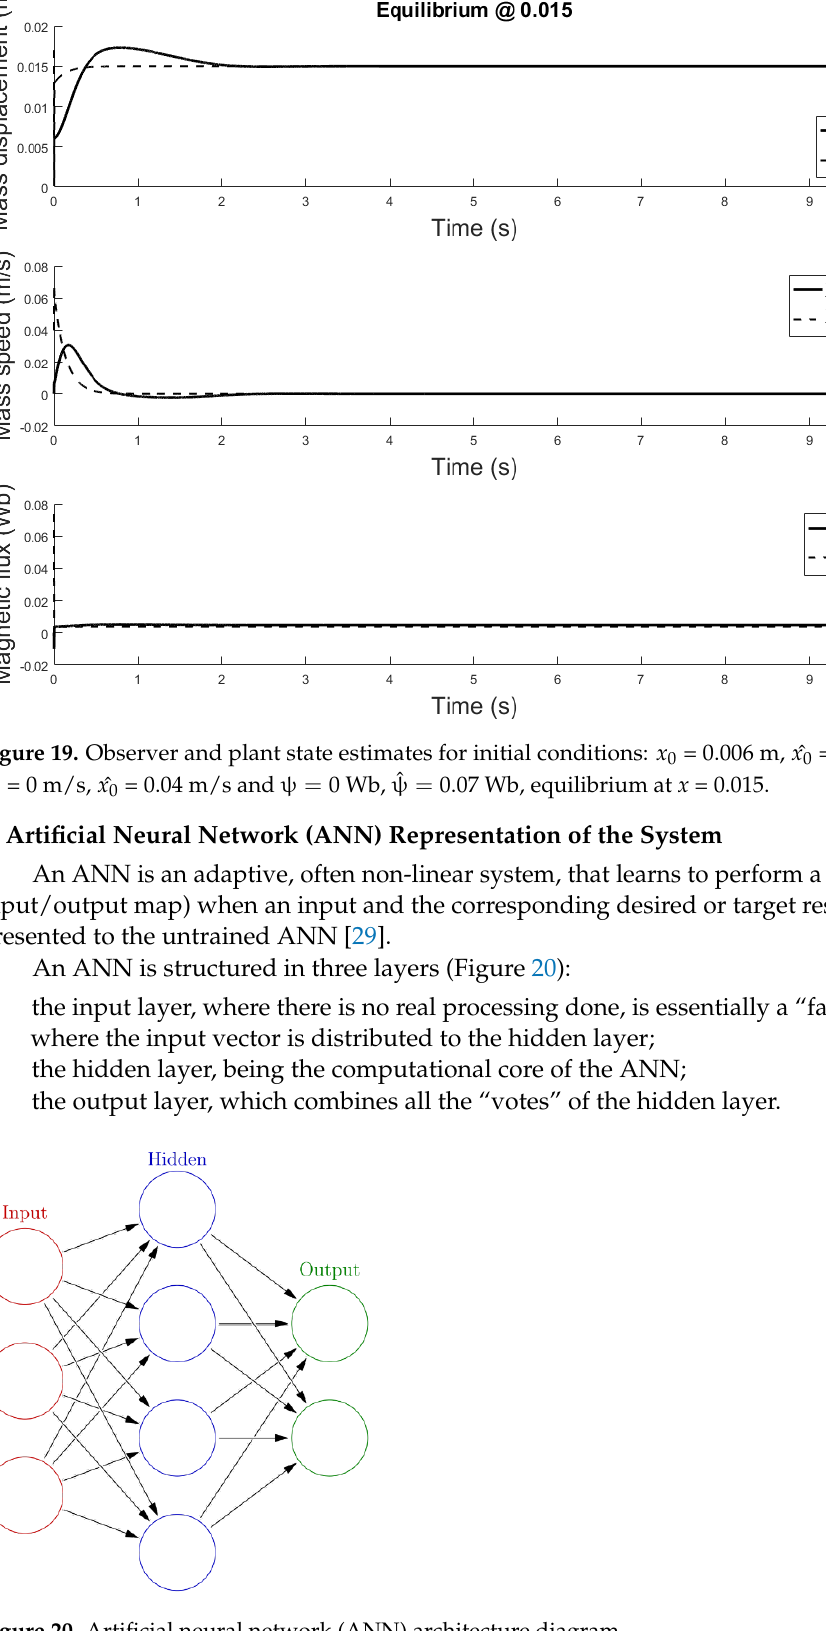
Figure 18. Observer and plant state estimates for initial conditions: